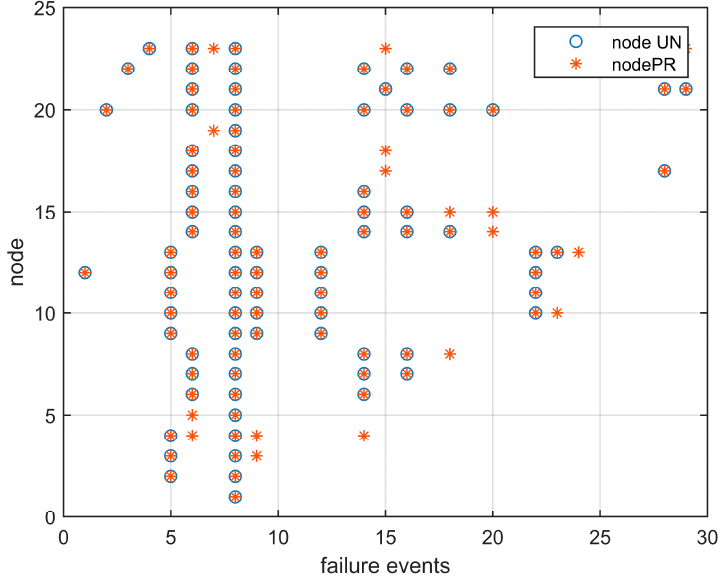
Figure 2. Example of a scatter plot of critical nodes that are affected by each failure event identified by node ID